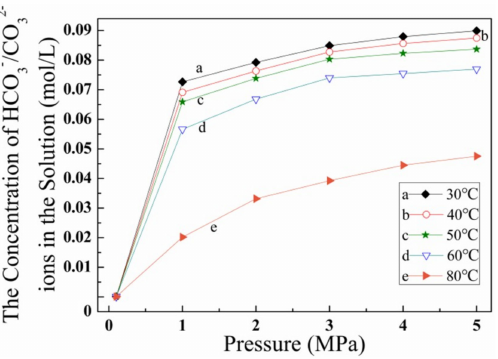
Figure 7. Concentration of the HCO 3 − /CO 32 − ions in the formation solution at different temperatures and pressures.